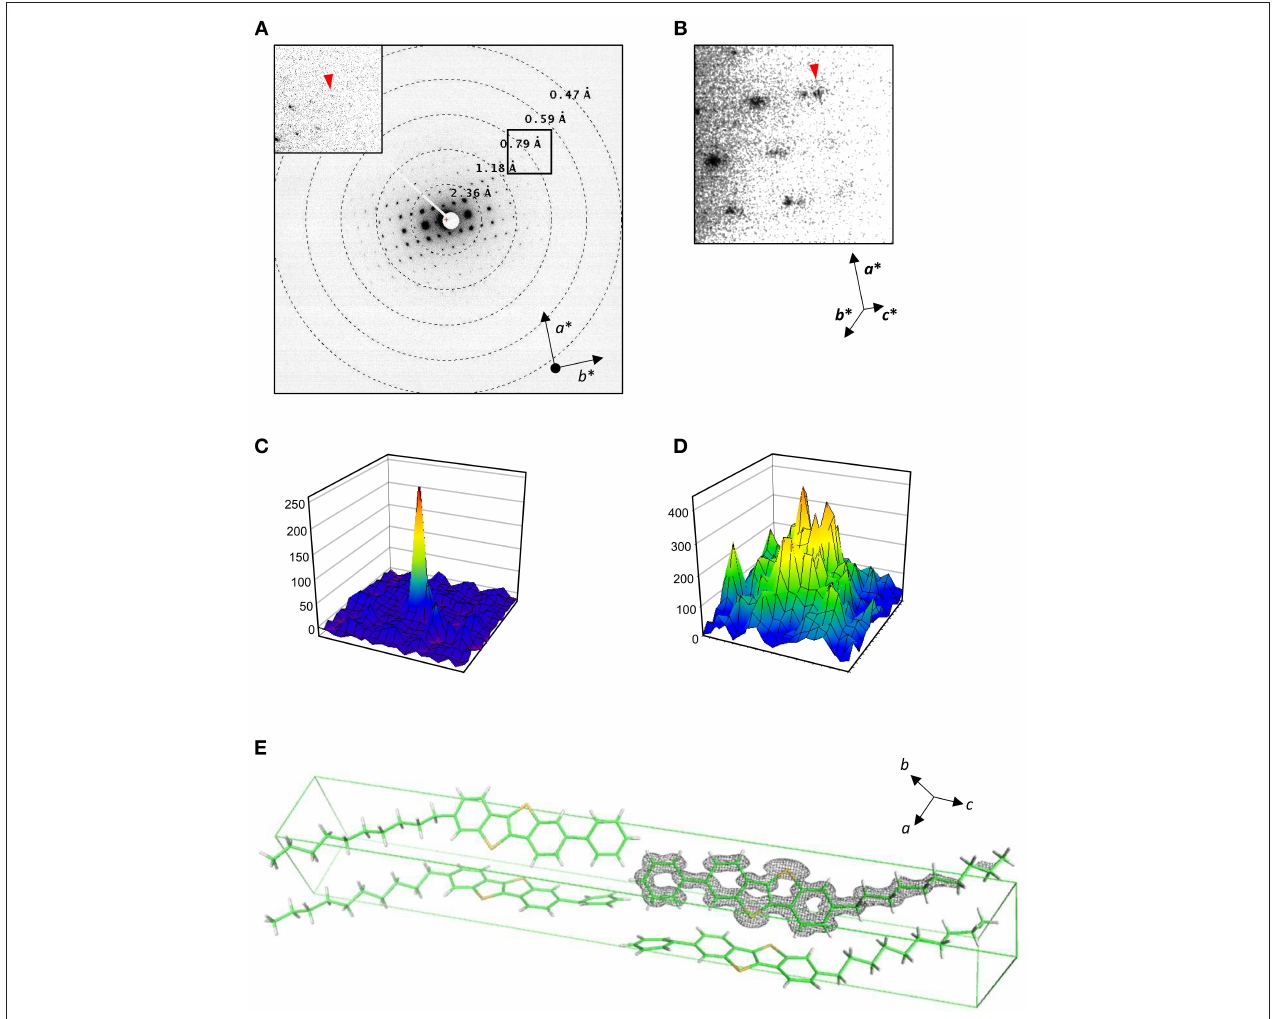
FIGURE 4 | Structure analysis of Ph-BTBT-C10. (A,B) Electron diffraction patterns at lower tilt angles covering 4.5–5.0 ◦ (A) and a zoom-up at higher tilt angles covering − 50 to − 49.5 ◦ (B) . Inset in (A) shows a zoom-up of a square. Reciprocal cell axes are shown with arrows. (C,D) Intensity profiles in 19 × 19 pixels for diffraction spots with arrow heads in (A) and (B) , respectively. (E) Atomic models determined in this study, containing four molecules in the unit cell. A Coulomb potential map ( σ A -weighted 2 | F obs | – | F calc | map) is overlaid on one molecule. Gray nets are contoured at 1.5 σ . The cell axes are shown with arrows.